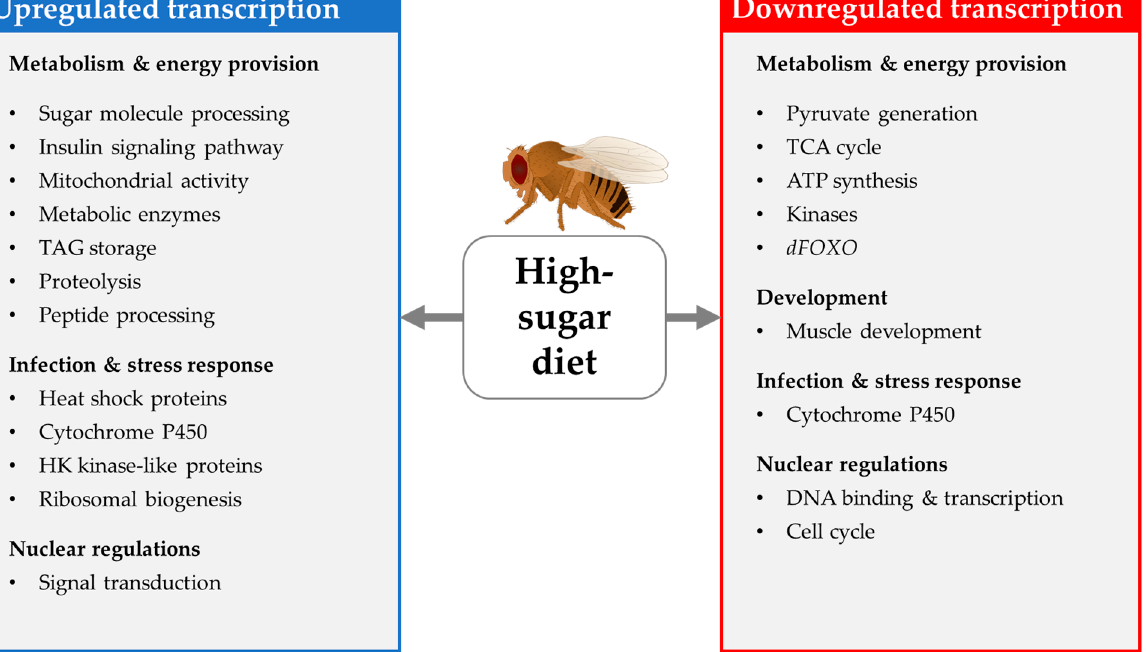
Figure 12. Transcriptional alterations following intake of a high-sugar diet (HSD) in Drosophila melanogaster . Ingestion of an HSD causes upregulation (blue box) and downregulation (red box) of genes involved in metabolism and energy provision, infection and stress responses, nuclear regulation, and development (modified from [128,135,151–153]).